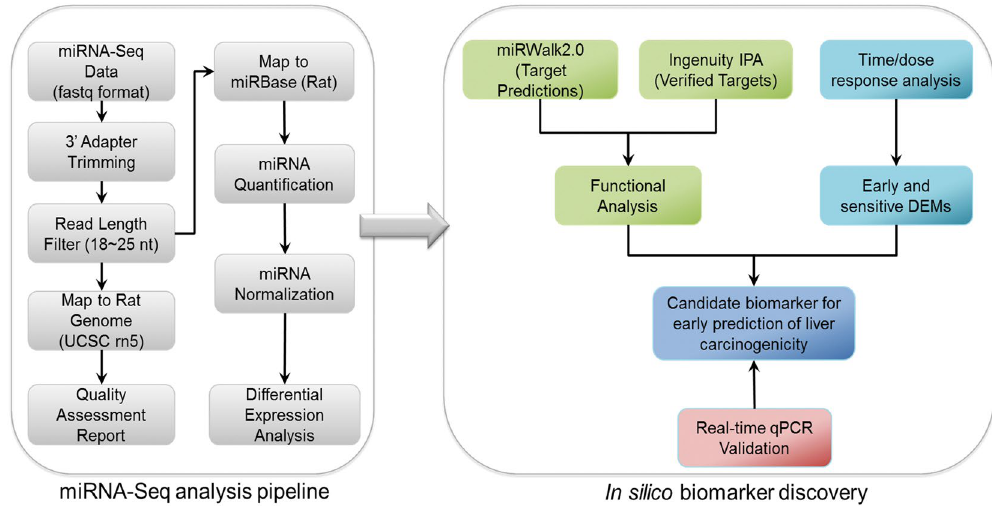
Figure 1. A schematic illustration of the workflow used in the present study to elucidate differentially expressed miRNAs during TAA-induced hepatocarcinogenesis. This workflow can be broadly divided into two sections: miRNA-Seq analysis pipeline and in silico biomarker discovery. In miRNA-Seq analysis pipeline, briefly, the adaptor sequence was trimmed from the fastaq files obtained from Illumina HiSeq2000 platform and then reads with a length between 18 to 25 bases were selected to map to the Rattus norvegicus (rn5) genome. Quality control and assessment were carried out on the selected dataset. In a next step, reads were mapped against miRBase (rat) and quantification and normalization were performed to obtain DEMs. In the second section, functional association (using miRWalk2.0 and Ingenuity IPA) and time/dose response analyses were conducted to identify early and sensitive DEMs and their possible regulatory signaling in TAA-induced liver carcinogenicity. Thereafter, qPCR experiments were performed to validate potential biomarker. Information about the programs and their parameters used in this workflow is given in detailed under the Methods